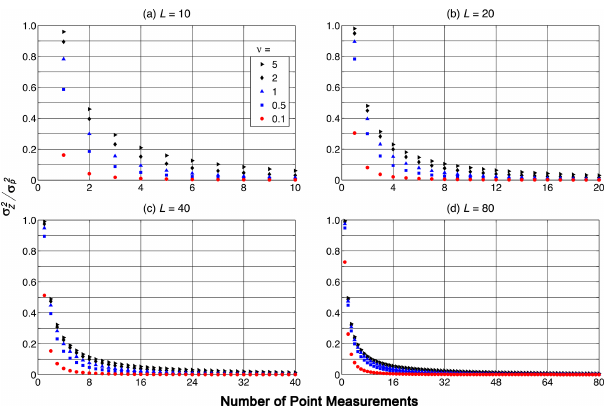
. σ 2 p ) for the Z